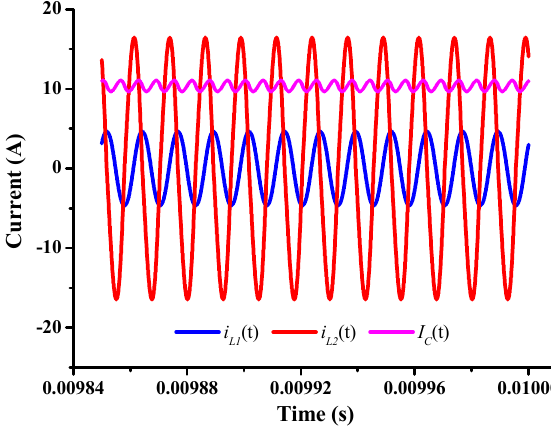
Figure 10. Dynamic characteristics of the currents in the